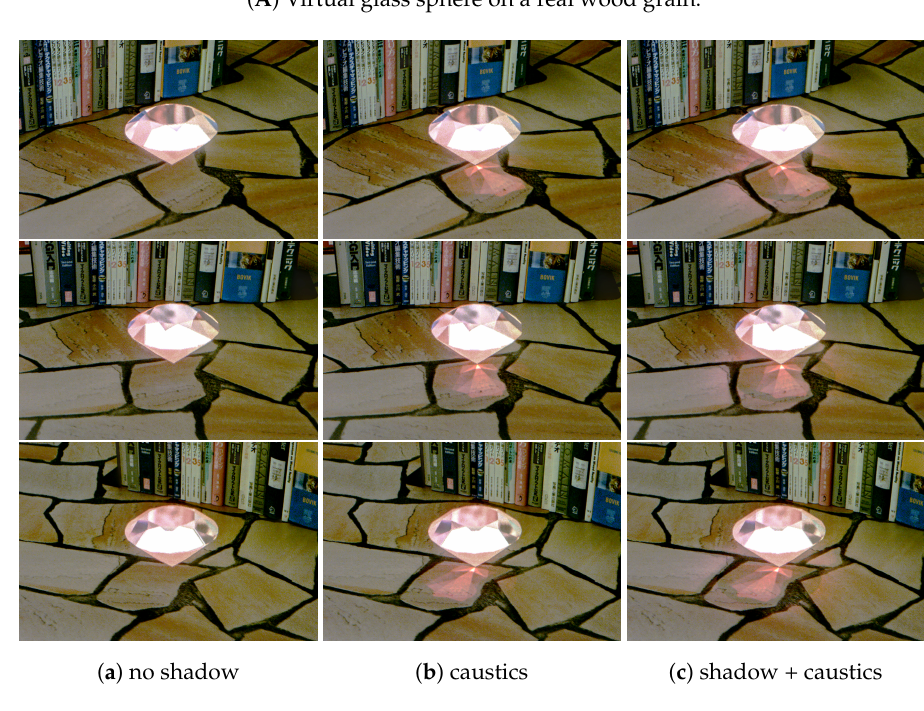
Figure 3. Virtual transparent objects represented under different conditions.